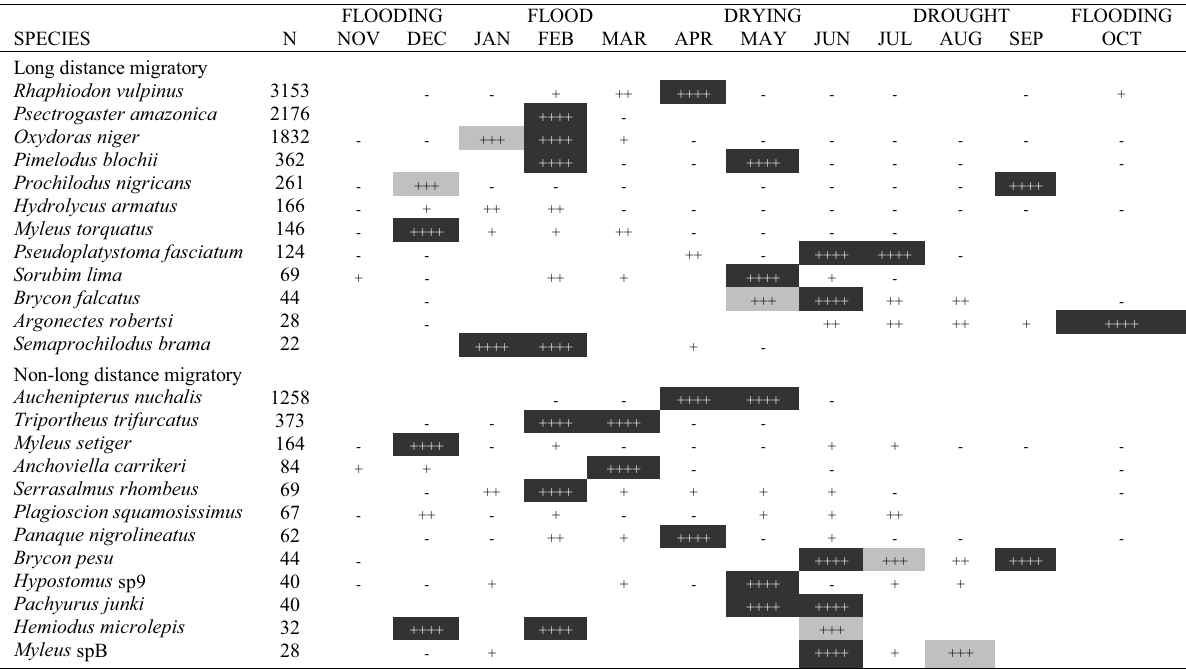
Table 1. Number (N) and abundance of migratory and non-migratory fish species by month and phase of the hydrological cycle. Only species present in the ladder with a number of individuals greater than 20 were included. The percentage of the catch per unit of effort, in number, is represented by: - = <10%; + = 10 to 15%; ++ =15 to 20%; +++ =20 to 25% and ++++ = >25% Empty cell = no